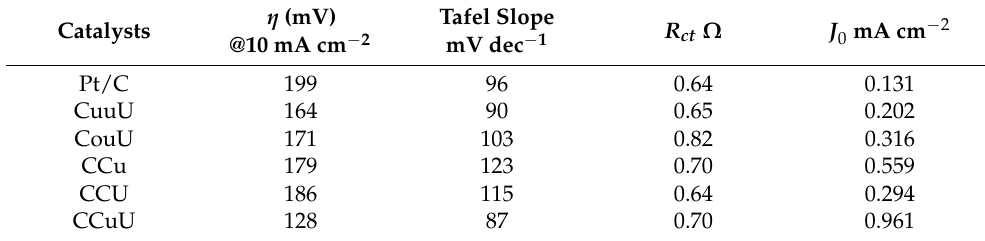
Figure 7. ( A ) LSV plots, ( B ) Comparison of overpotentials at different current densities, ( C ) Tafel plot, and ( D ) EIS diagram (inset: EEC) of catalysts in 1 M KOH. Table 4. Account of catalytic activities of the catalysts in 1 M KOH.